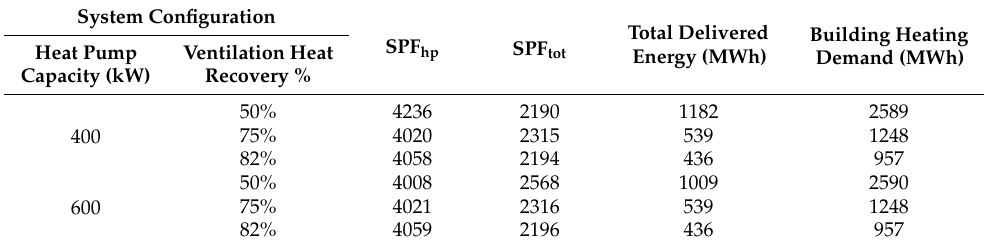
Table 2. Variation of performance indicators with ventilation heat recovery percentage and heat pump